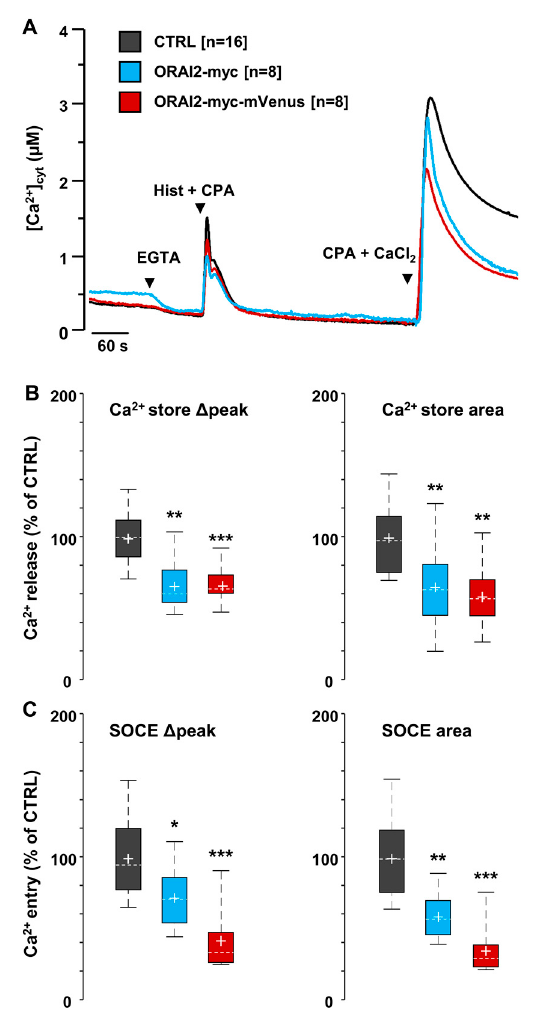
Figure 1. ORAI2 overexpression reduces ER Ca 2 + release and SOCE in H4 cells. Representative traces of H4 cells expressing ORAI2-myc or ORAI2-myc-mVenus, STIM1 and cyt-AEQ in a 2:6:1 ratio. ( A ) Cells were bathed, under perfusion at 37 ◦ C, in mKRB containing CaCl 2 (1 mM). Upon shifting to a Ca 2 + -free mKRB containing EGTA (0.6 mM), cells were challenged with histamine (Hist, 100 µ M) and CPA (20 µ M) in the same medium. After 8 min, cells were bathed in mKRB containing CaCl 2 and CPA to detect maximal SOCE amplitude. Boxplots show Ca 2 + release ( B ) and SOCE (C ) peak height and AUC, upon baseline subtraction. Data are expressed as percentage of control (CTRL) cells expressing only STIM1 and cyt-AEQ. Coverslips were from at least three independent cell batches. Wilcoxon-Mann-Whitney test (* p < 0.05; ** p < 0.01; *** p < 0.001).